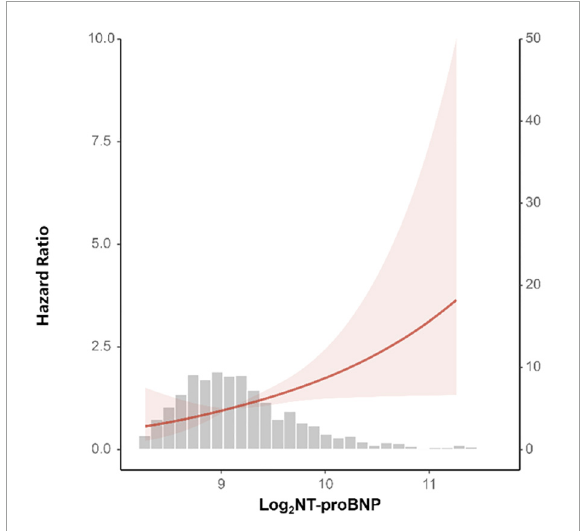
FIGURE2 A restricted cubic spline analysis of the association between baseline NT-proBNP level and major cardiovascular event (MACE) risk. Baseline log 2 transformed NT-proBNP level presented a linear relationship with the risk of MACE ( p for non-linearity = 0.891). The curves are presented with 95% confidence interval ( CI ).